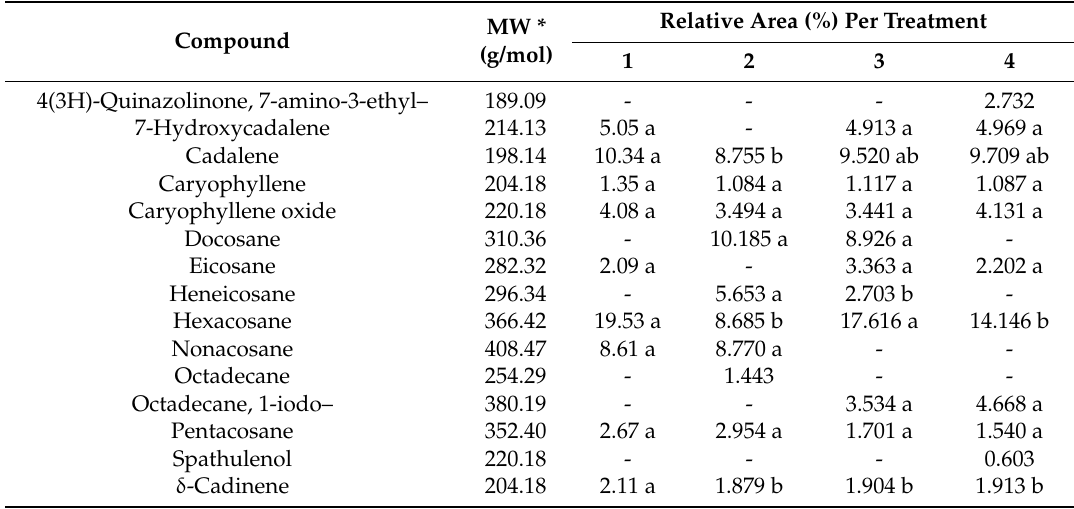
Table 3. Gas chromatography-mass spectroscopy (GC-MS) composition of the different treatments of Mexican arnica supercritical extracts. The relative areas are shown in percent. Statistical difference between treatments is denoted by letters a and b.